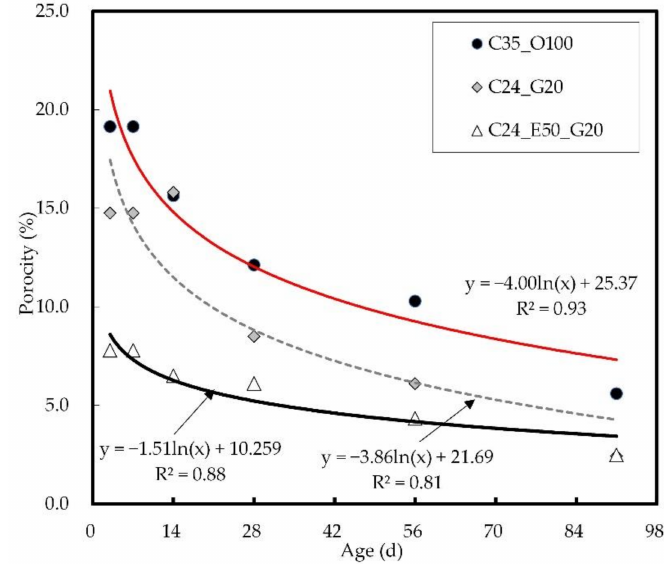
Figure 10. Result of internal porosity of concrete by